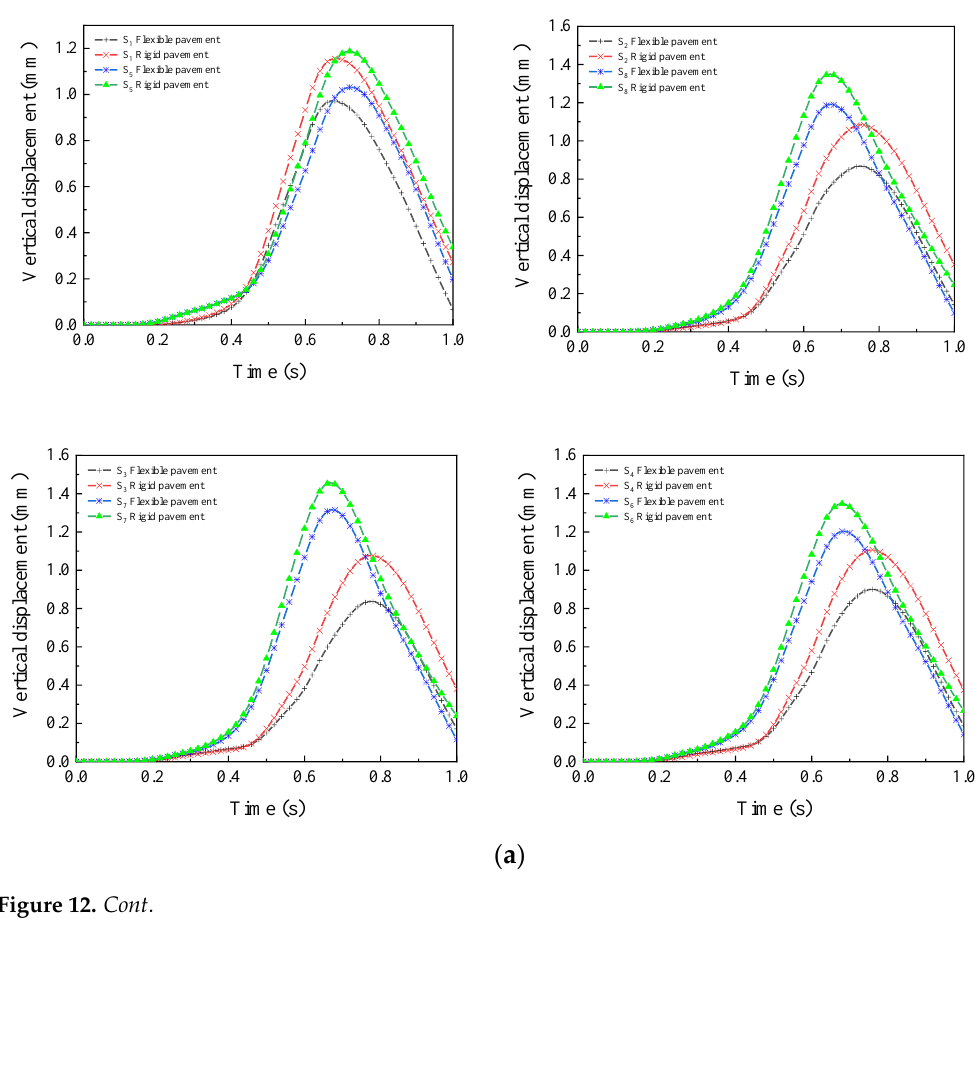
Figure 11. A vertical displacement diagram of the pavement structure.